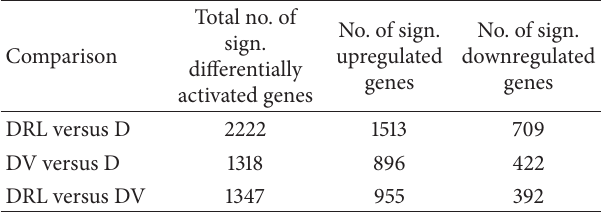
Table 2: The number of identified genes with different expression levels when the various test groups were subjected to pair group comparisons. Total no. of No. of sign. No. of sign. Comparison differentially activated genes